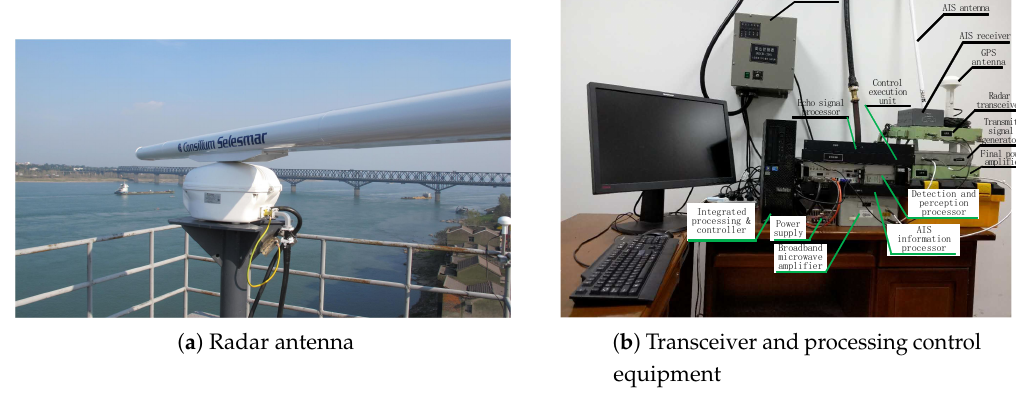
Figure 7. Radar experimental system experimental test